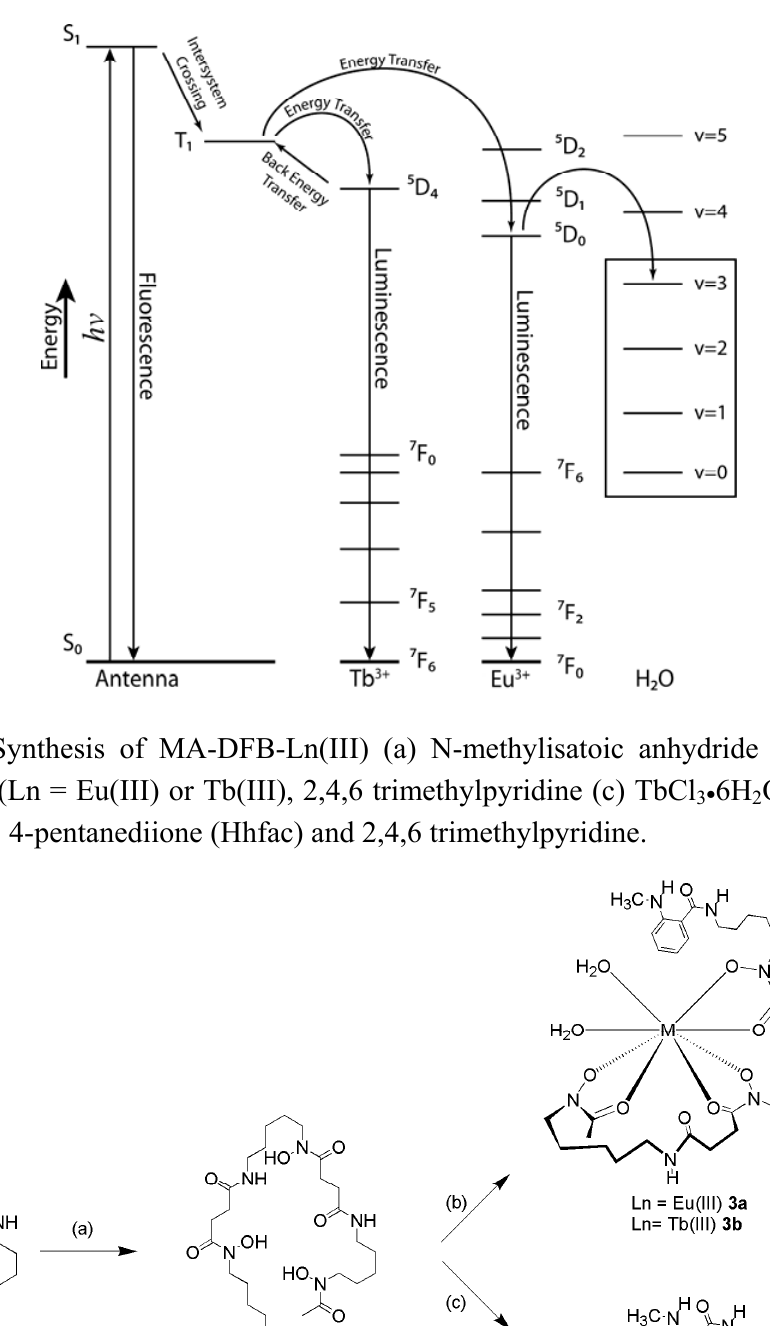
Figure 2. Electronic energy level diagrams for Tb 3+ and Eu 3+ . Radiationless energy transfer competes with the radioactive process through coupling of the emissive states to the O-H vibrational overtones of the coordinated water